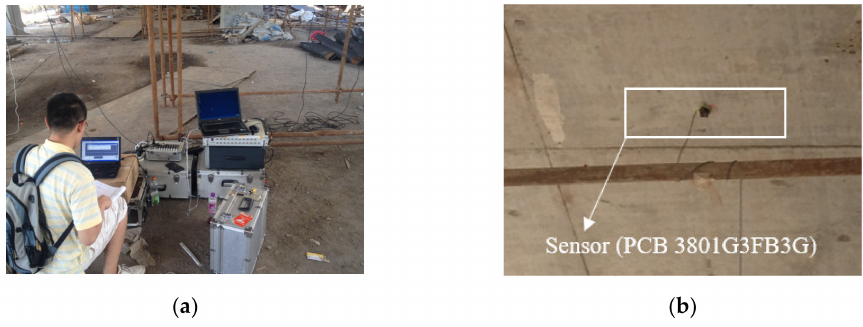
Figure 11. Photographs of the ( a ) data acquisition device and ( b ) accelerometers used for the load test of the actual beam bridge.